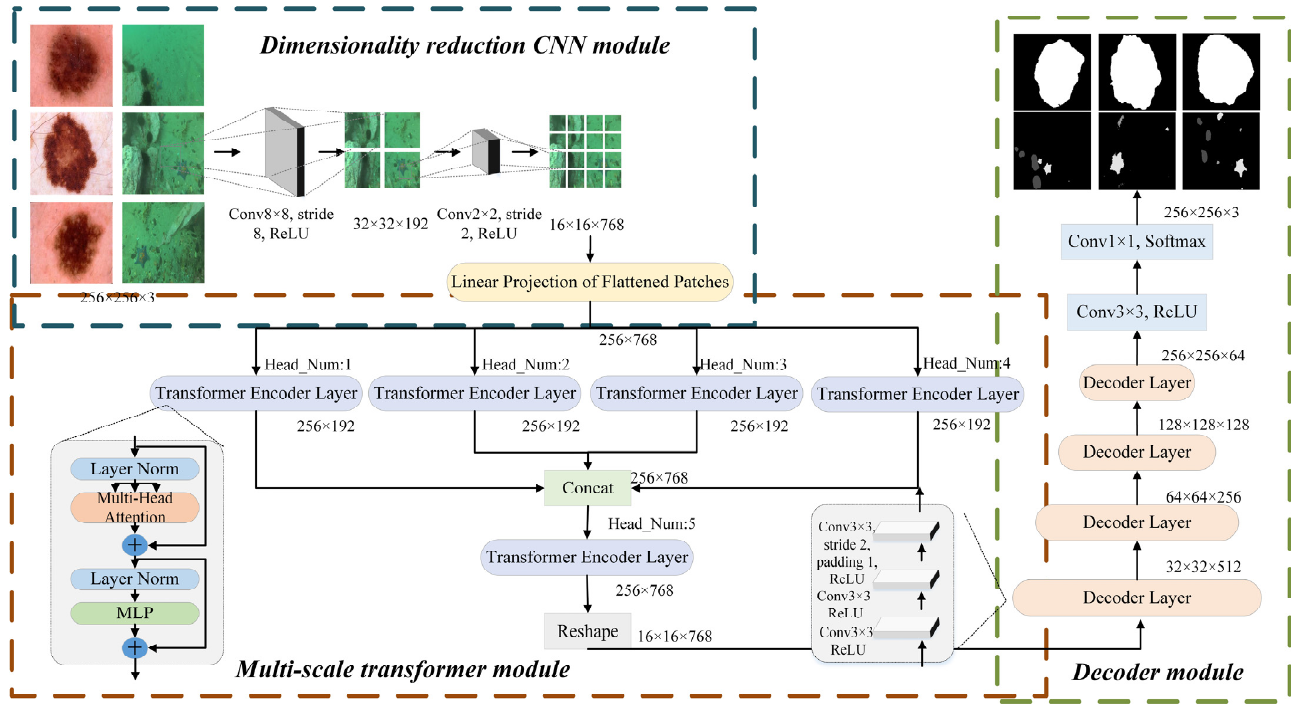
Figure 1. The detailed structure diagram of